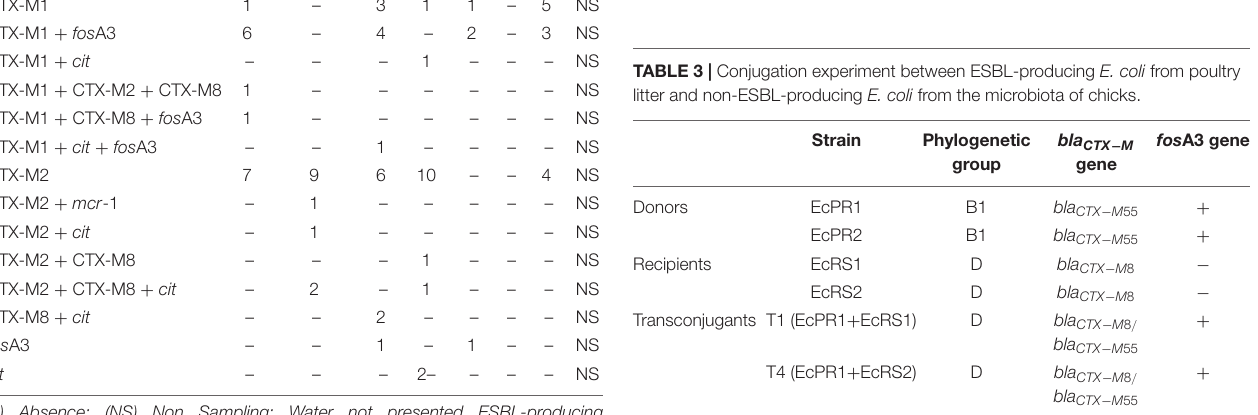
TABLE 2 | Distribution of ESBL-producing E. coli strains based on a combination of genes (or CTX-M group genes) and sources in PR and RS states. Poultry litter Poultry